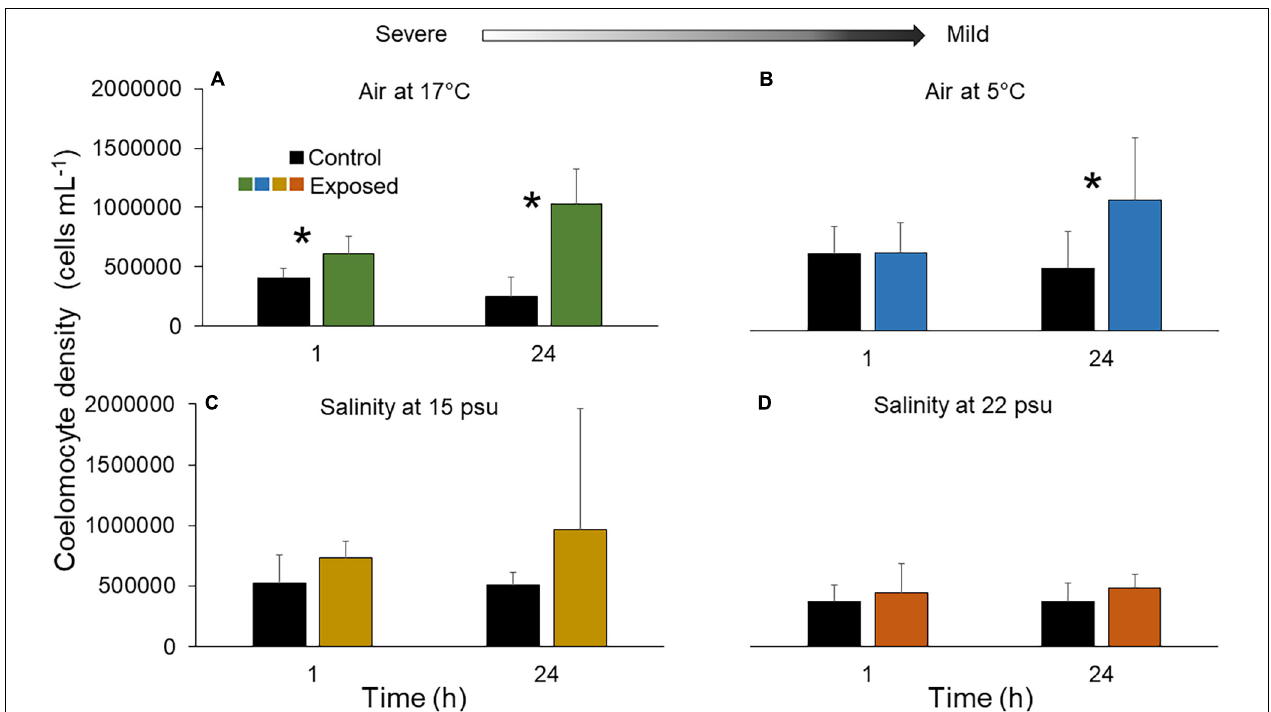
FIGURE 1 | Density of free coelomocytes in fluid of the Polian vesicle (mean ± SD, n = 5–10) after exposure of sea cucumbers to (A) 17 ◦ C air (B) 5 ◦ C air (C) 15 psu salinity and (D) 22 psu salinity. The asterisk (*) indicates significant differences between control and exposed individuals ( p < 0.05) at each time point. There is no statistical difference between treatment groups at different time points ( p > 0.05). Arrow indicates severe and mild stressors relative to the control. Measurements were made immediately after the exposure (1 h) and after a 23 h recovery period (total of 24 h). Main statistical results are shown in Supplementary Table 2 .